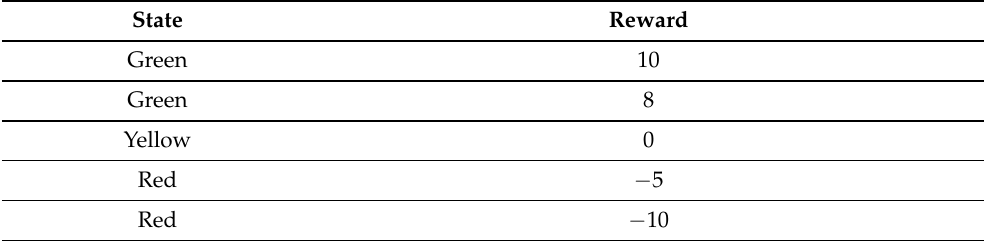
Table 2. Tesseratus reward